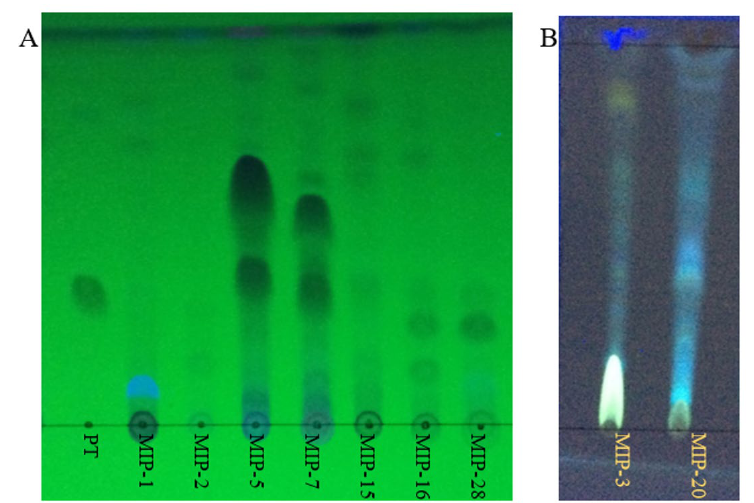
Fig. 2. Thin layer chromatograms (A) shows the DCM extracts of fungal isolates with putative taxol bands. PT denotes the paclitaxel (Sigma-Aldrich). MIP denotes the fungal extracts from different isolates. (B) shows the fluorescent bands in the DCM extracts of fungal isolates (MIP-3 and